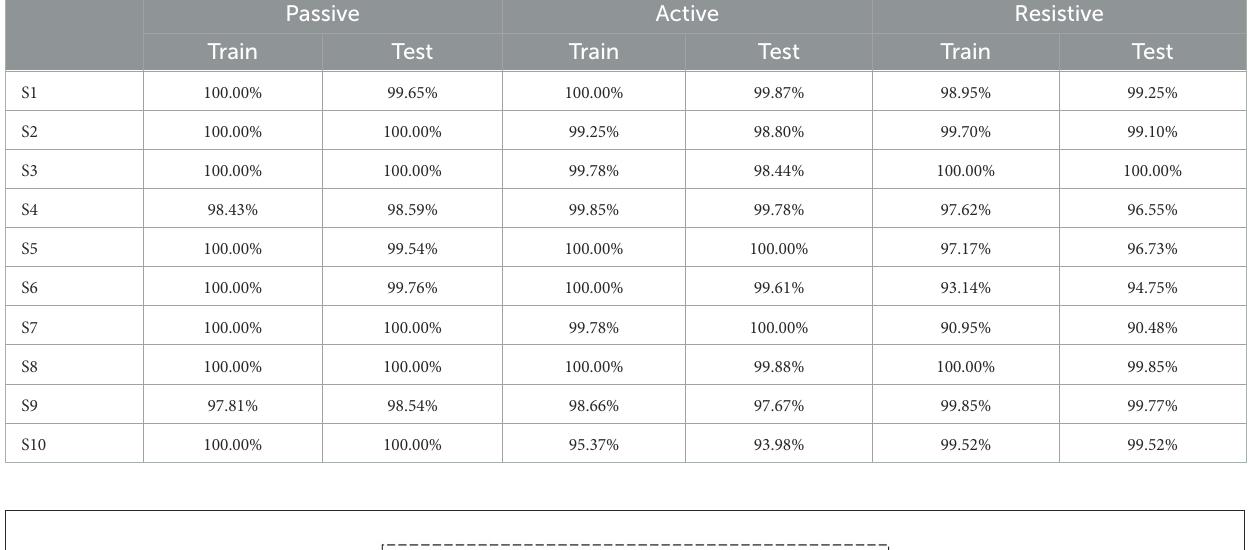
TABLE 1 The classification accuracy of 10 participants in three training stages in offline condition.